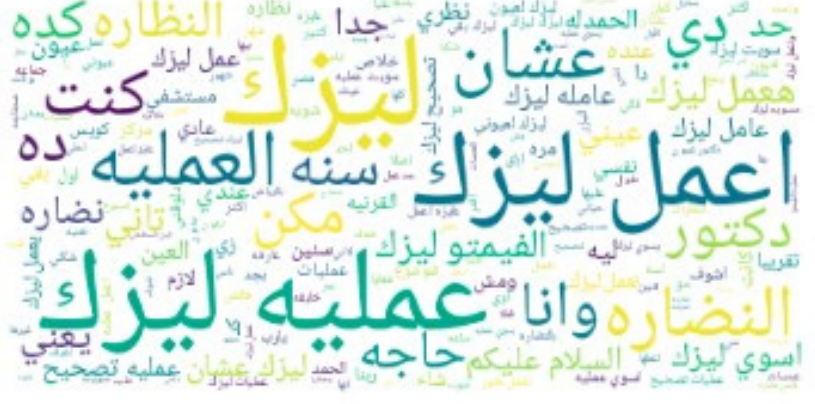
Figure 2. Word Cloud across collected LASIK surgery data set.